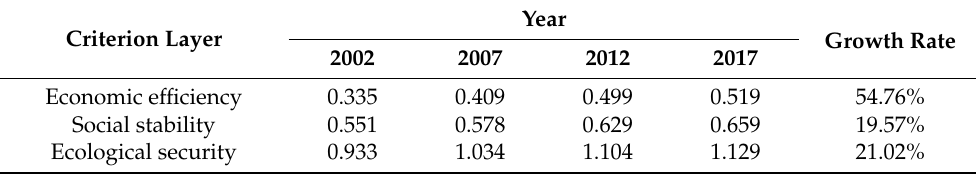
Table 4. Comprehensive scores change of three indicators of criterion layer in Central